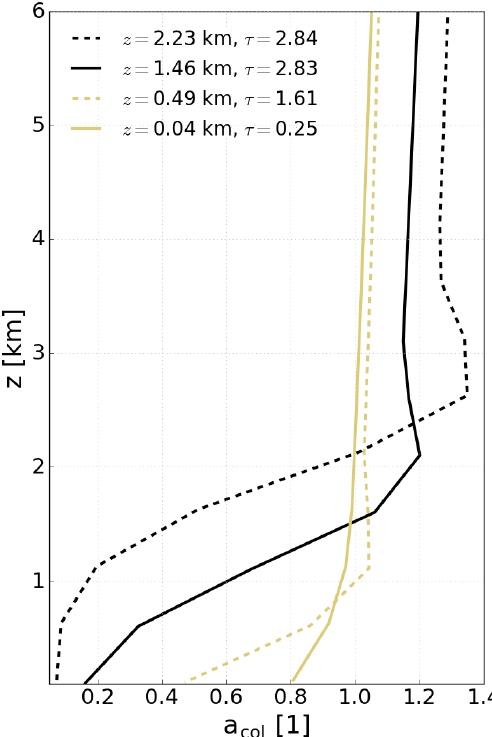
Figure 1. SCIAMACHY CO total column averaging kernels for different cloud centre heights ( z cld ) and cloud optical thicknesses ( τ cld ). Here, the solid yellow line is representative of clear-sky con- ditions. The figure shows typical cases of the vertical retrieval sen- sitivity of the SCIAMACHY CO retrievals over